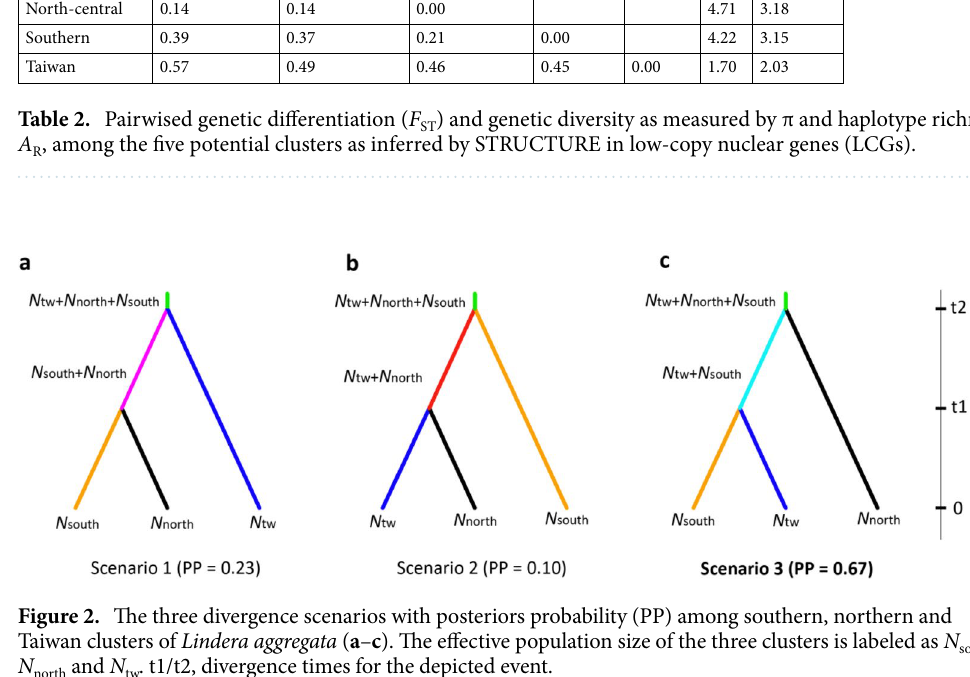
N south N tw N north